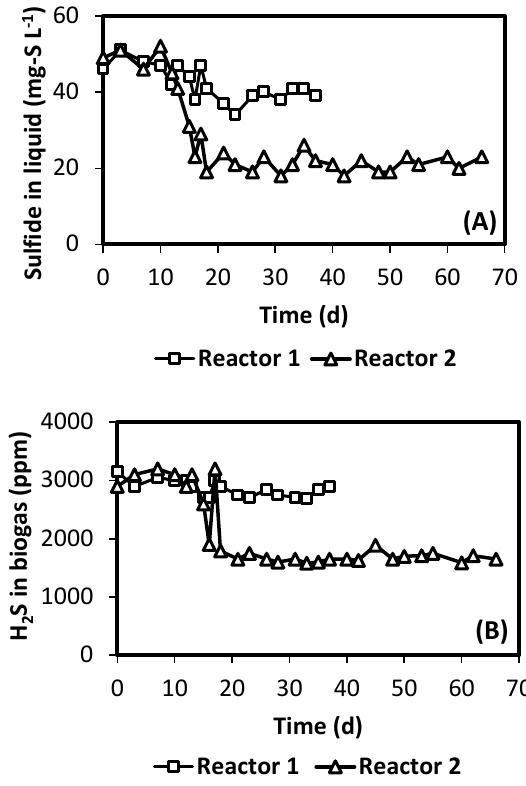
Figure 2. Concentration of sulfide in liquid effluent ( A ) and biogas ( B ) during UASB reactors operation.